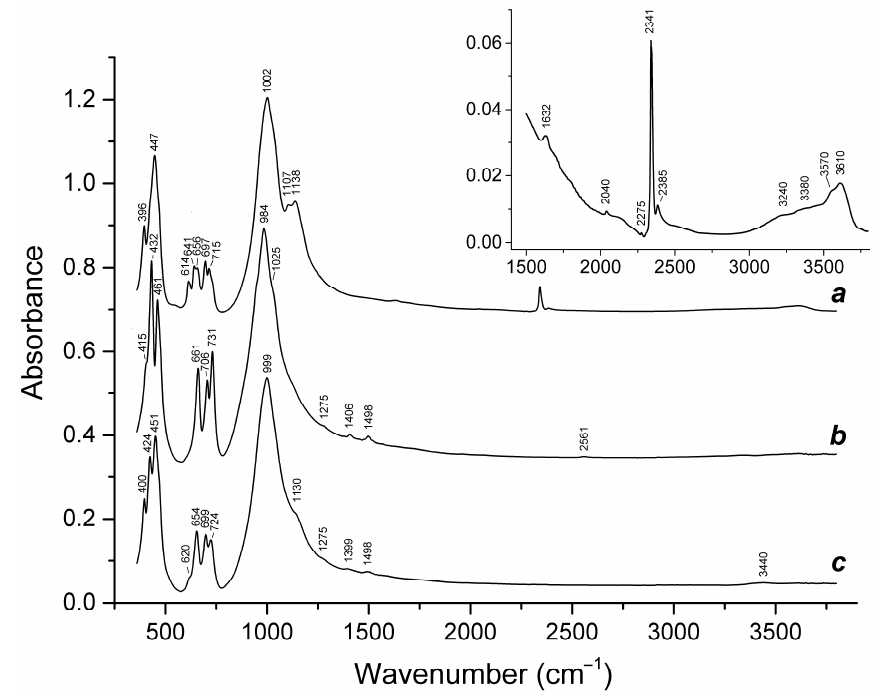
Figure 19. Infrared spectra of ( a ) initial slyudyankaite (Sample 6), ( b ) Sample 6 preheated for three days at 700 ◦ C, over the Fe-FeS buffer, and ( c ) preheated Sample 6 additionally annealed at 800 ◦ C in air for one day. The inset shows the IR spectrum of initial Sample 6 in the range of 1500–3800 cm − 1 .